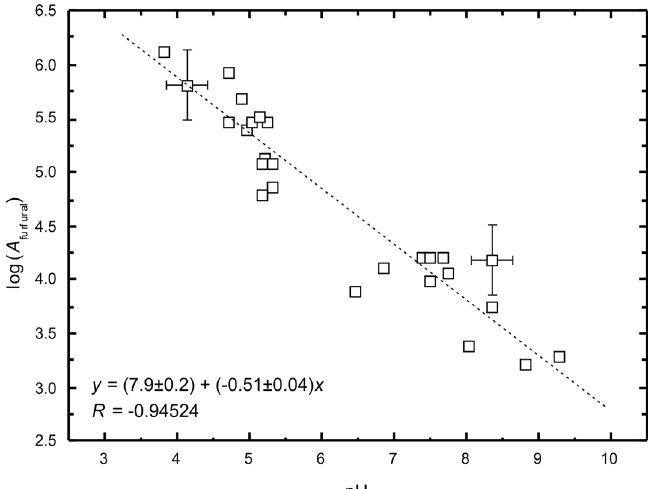
Figure 4. Comparison of chromatographic peak areas for furfural emitted by paper samples (Table 1) after an 18-h annealing period in a glass vial and equilibrium pH of the same samples. Conditions of extraction using SPME fibre: 40 o C, 1 h. Error bars represent typical uncertainties.